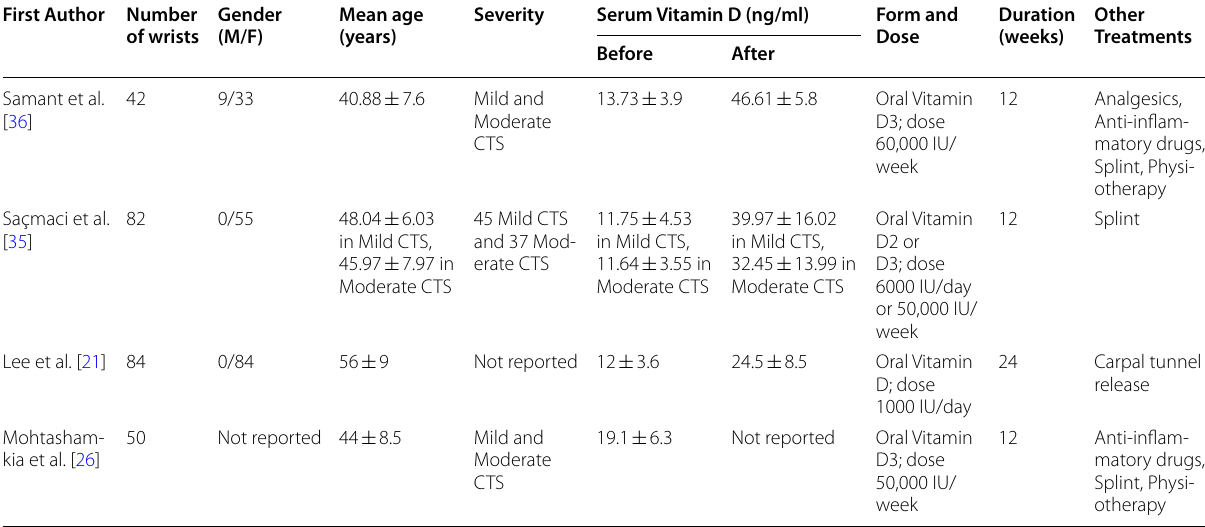
CTS Carpal tunnel syndrome; IU International